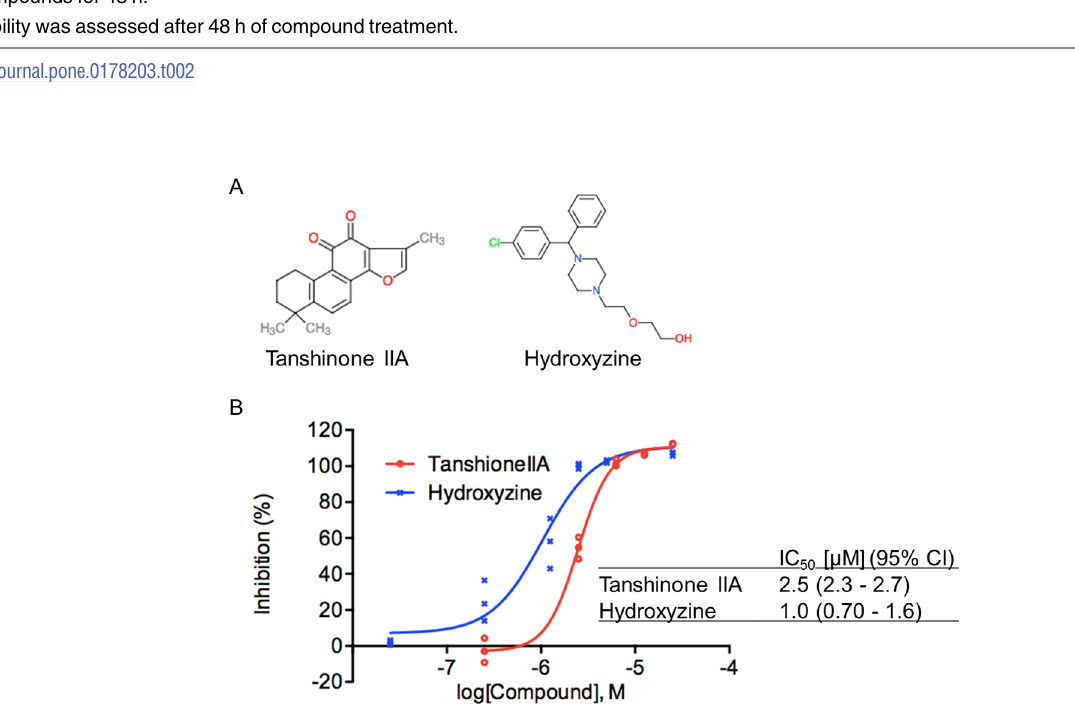
Fig 2. Tanshinone IIA and hydroxyzine display dose-dependent inhibitory effects on Toxoplasma gondii growth. (A) Structures of tanshinone IIA and hydroxyzine. (B) Dose-response responsecurves and IC 50 values for tanshinone IIA and hydroxyzine. HFF cells infected with RH-2F parasites were incubatedwith variousconcentrations of the test compoundsand parasite growth was measuredby using the β - galactosidase assay. Inhibitionrates were calculatedusing DMSO as a negative control (0% inhibition)and 10 μ M pyrimethamine as a positive control (100% inhibition).